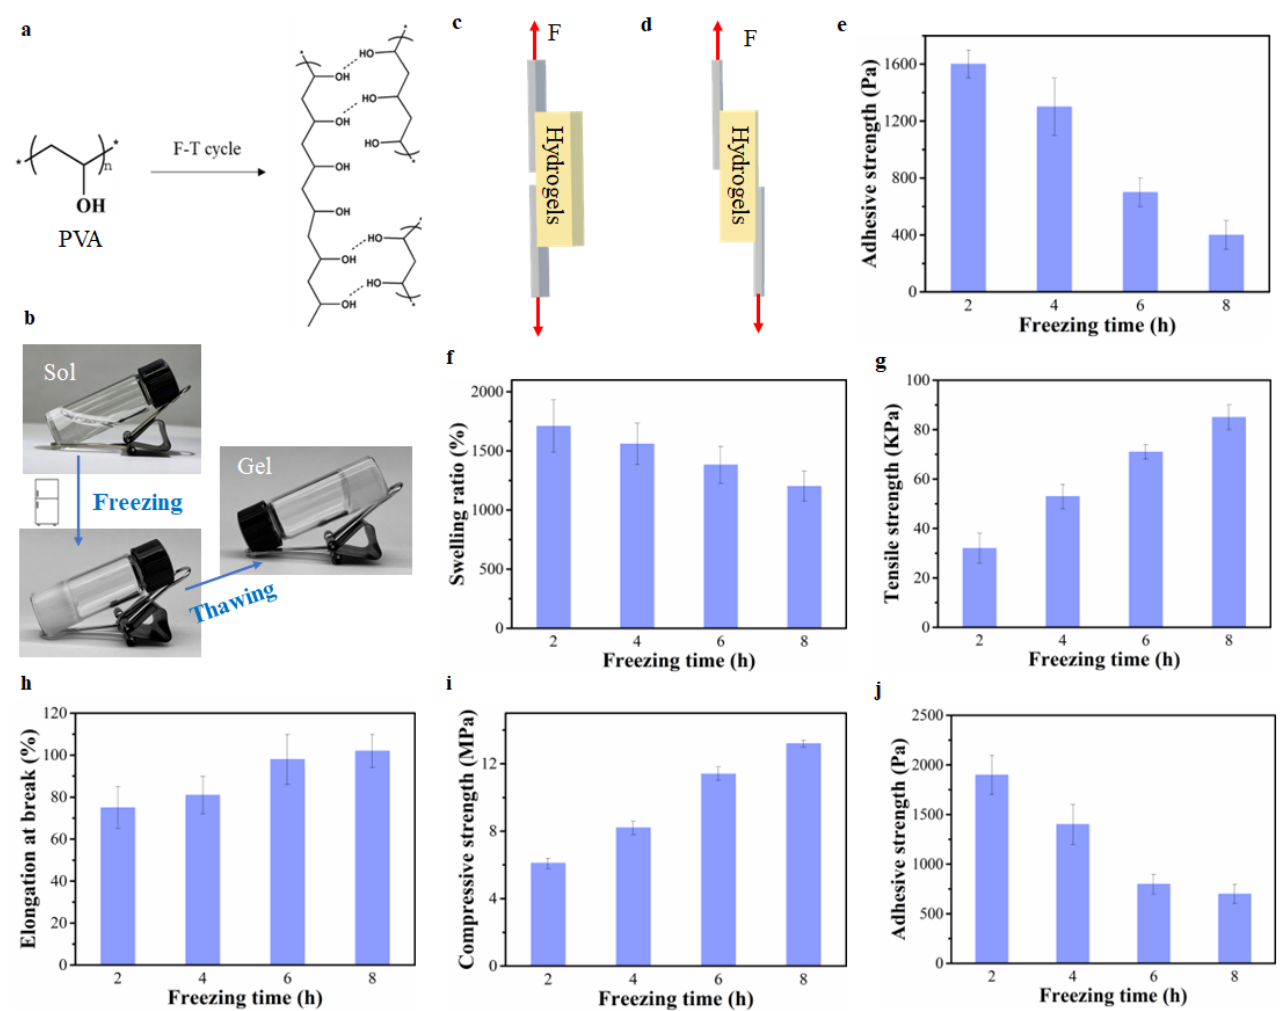
Figure 1. ( a ) The formation mechanism of PVA hydrogels. ( b ) The preparation process of PVA hydrogels. ( c ) The modified method of testing hydrogel adhesion used in this study. ( d ) The general method of testing hydrogel adhesion. ( e ) The adhesive strength of PVA hydrogels prepared by different freezing times. ( f ) The swelling ratio of PVA hydrogels prepared by different freezing times. ( g ) The tensile strength of PVA hydrogels prepared by different freezing times. ( h ) The elongation at break of PVA hydrogels prepared by different freezing times. ( i ) The compressive strength of PVA hydrogels prepared by different freezing times. ( j ) The adhesive strength of PVA/CNC hydrogels prepared by different freezing times.